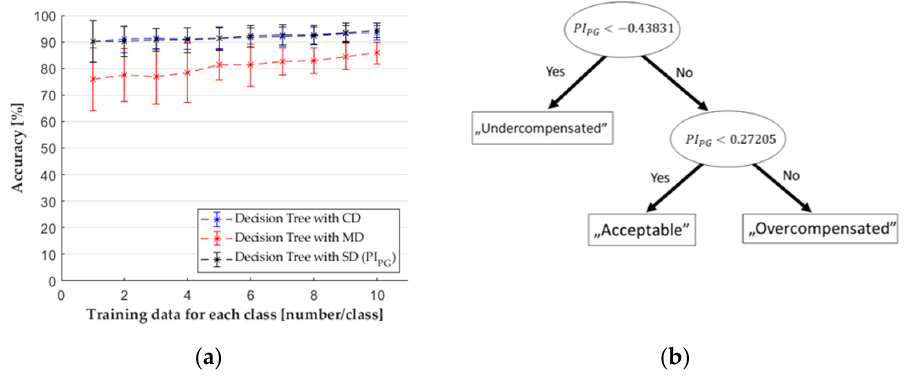
Figure 10. ( a ) The results of decision tree classifiers with different datasets; ( b ) a decision